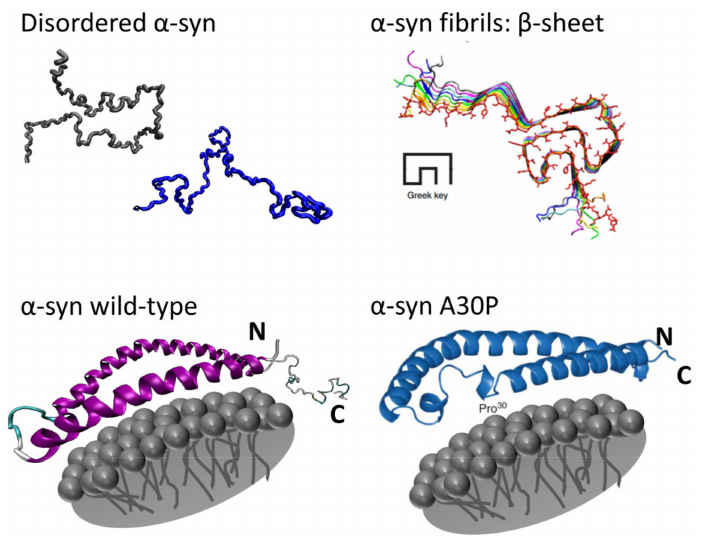
Figure 15. The different structures α -synuclein ( α -syn) can take. Reprinted with permission from ref. [104]. Copyright 2017 John Wiley and